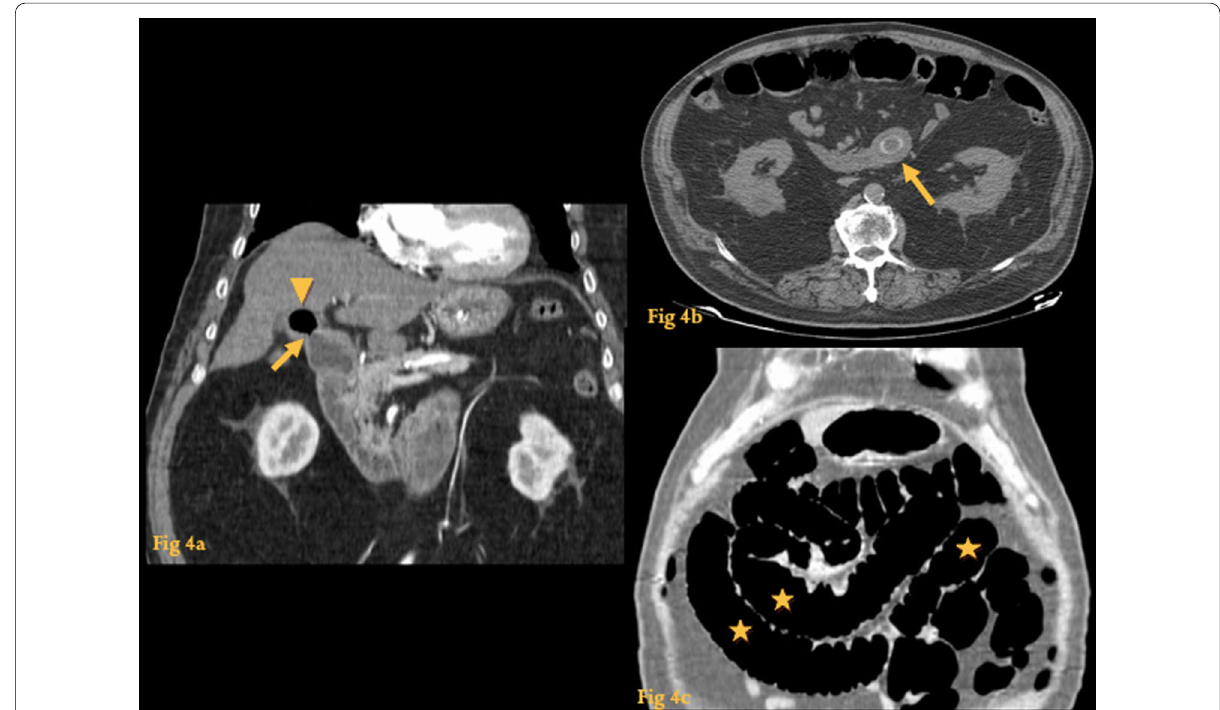
Fig. 4 Biliary ileus. CT coronal reformation ( a ) shows air in the gallbladder (arrowhead) and communication between its lumen and D2— cholecystoduodenal fistula (arrow). Axial CT scans ( b ) show a 2 cm‑wide elliptical gallstone impacted at the distal jejunum (arrow). Coronal reformation 9 c ) shows air‑filled dilated small bowel loops (asterisk)